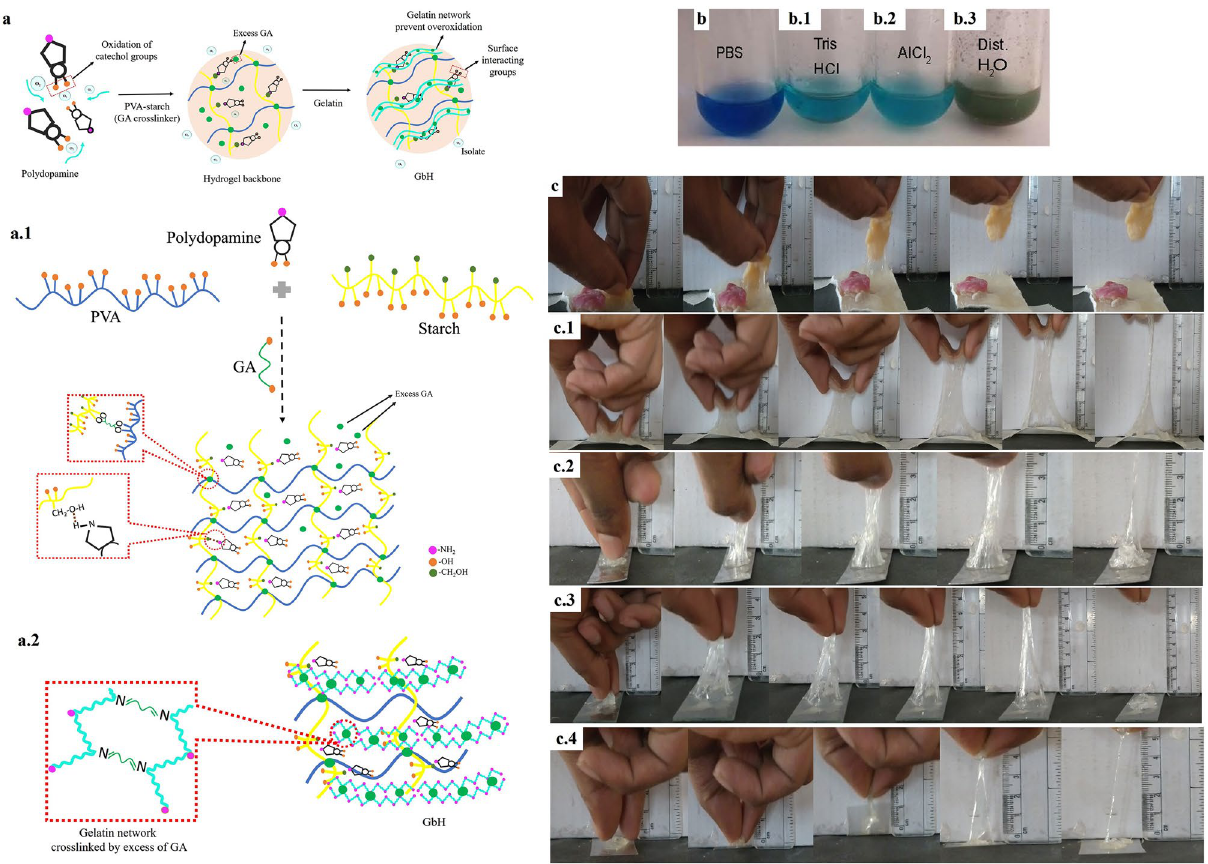
Figure 1. Schematic and diverse performance of GbH: ( a ) Schematic of the developed diverse surface gelatin- based hydrogel (GbH); ( a.1 ) The developed GbH is a two-stage process where polymers of polyvinyl alcohol (PVA) and starch, and the optimized alkali polymerized polydopamine concentration is chemically crosslinked with glutaraldehyde reagent (GA), which act as the base gel; ( a.2 ) The excess glutaraldehyde in the semi- polymerized stage crosslinks with gelatin and forms a polymer network over the base gel. The gelatin network prevents external oxygen and inhibits the oxidation of catechol groups.; The Benedict test was used to determine excess glutaraldehyde comprised: ( b ) PBS, ( b.1 ) Tris–HCl, ( b.2 ) AlCl 2 and ( b.3 ) distilled water. The developed GbH with stabilizer on diverse surfaces: ( c ) chicken; ( c.1 ) pork; ( c.2 ) stainless steel surface; ( c.3 ) glass surface and ( c.4 ) plastic